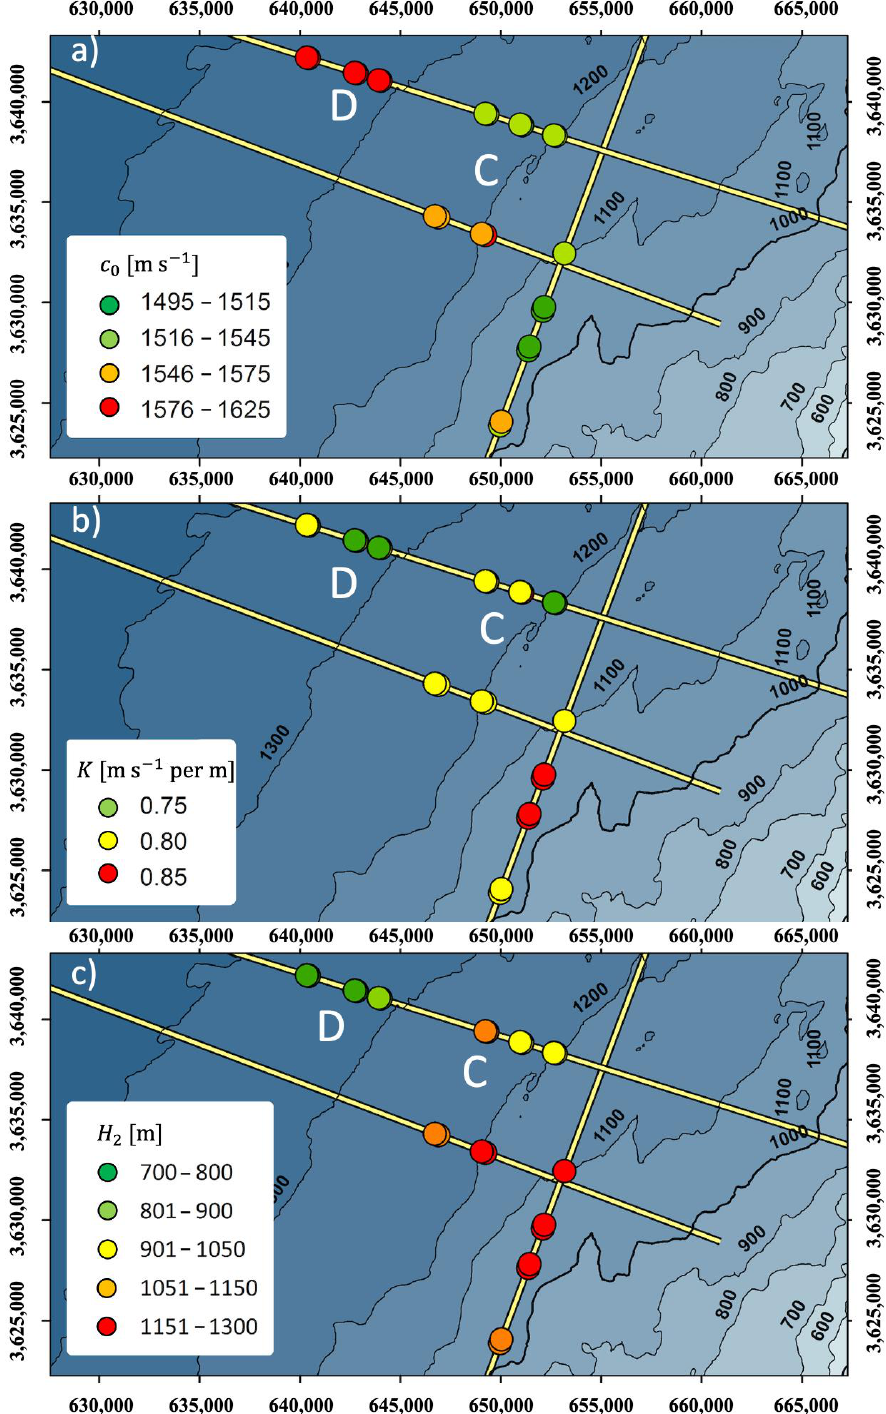
Figure 12. The spatial distribution of the estimated ( a ) seafloor sound speed 𝑐 0 , ( b ) sound-speed gradient 𝐾 , and ( c ) depth of the top salt 𝐻 2 , overlayed with the seafloor bathymetry (black contours) and the studied seismic lines (yellow lines). gradient K , and ( c ) depth of the top salt H 2 , overlayed with the seafloor bathymetry (black contours) Letters C and D represent the shallower and deeper parts of the study area, respectively. and the studied seismic lines (yellow lines). Letters C and D represent the shallower and deeper parts of the study area,